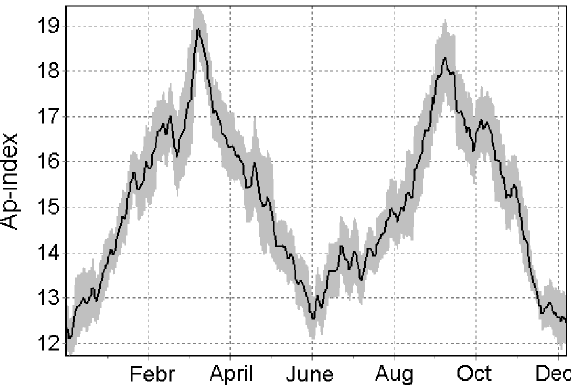
Fig. 5. Seasonal behavior of the A p -index averaged over the last 137 years. A p indices have been averaged since 1932, and before this time the aa-indexes were normalized.